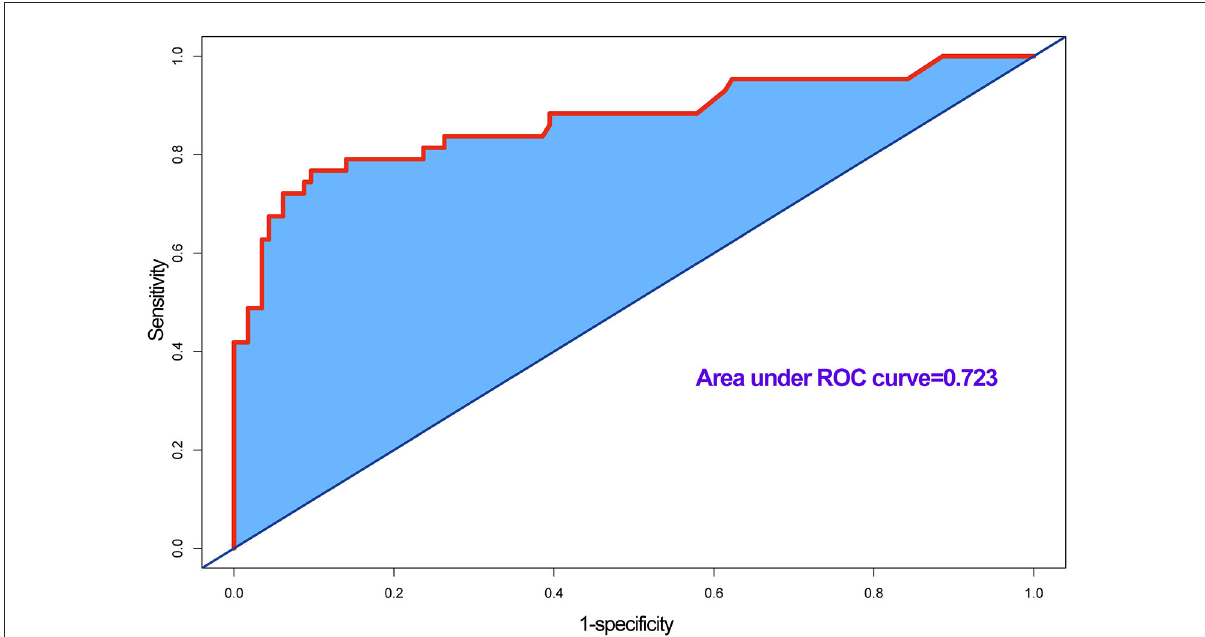
FIGURE4 Receiver operating characteristic (ROC) curve for evaluating the discrimination performance of the model, area under ROC curve was 0.723, and concordance (C) statistic was